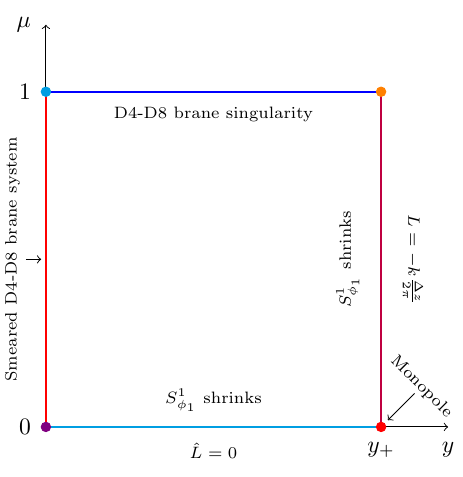
× S 1 fibers are defined. Within z φ 1